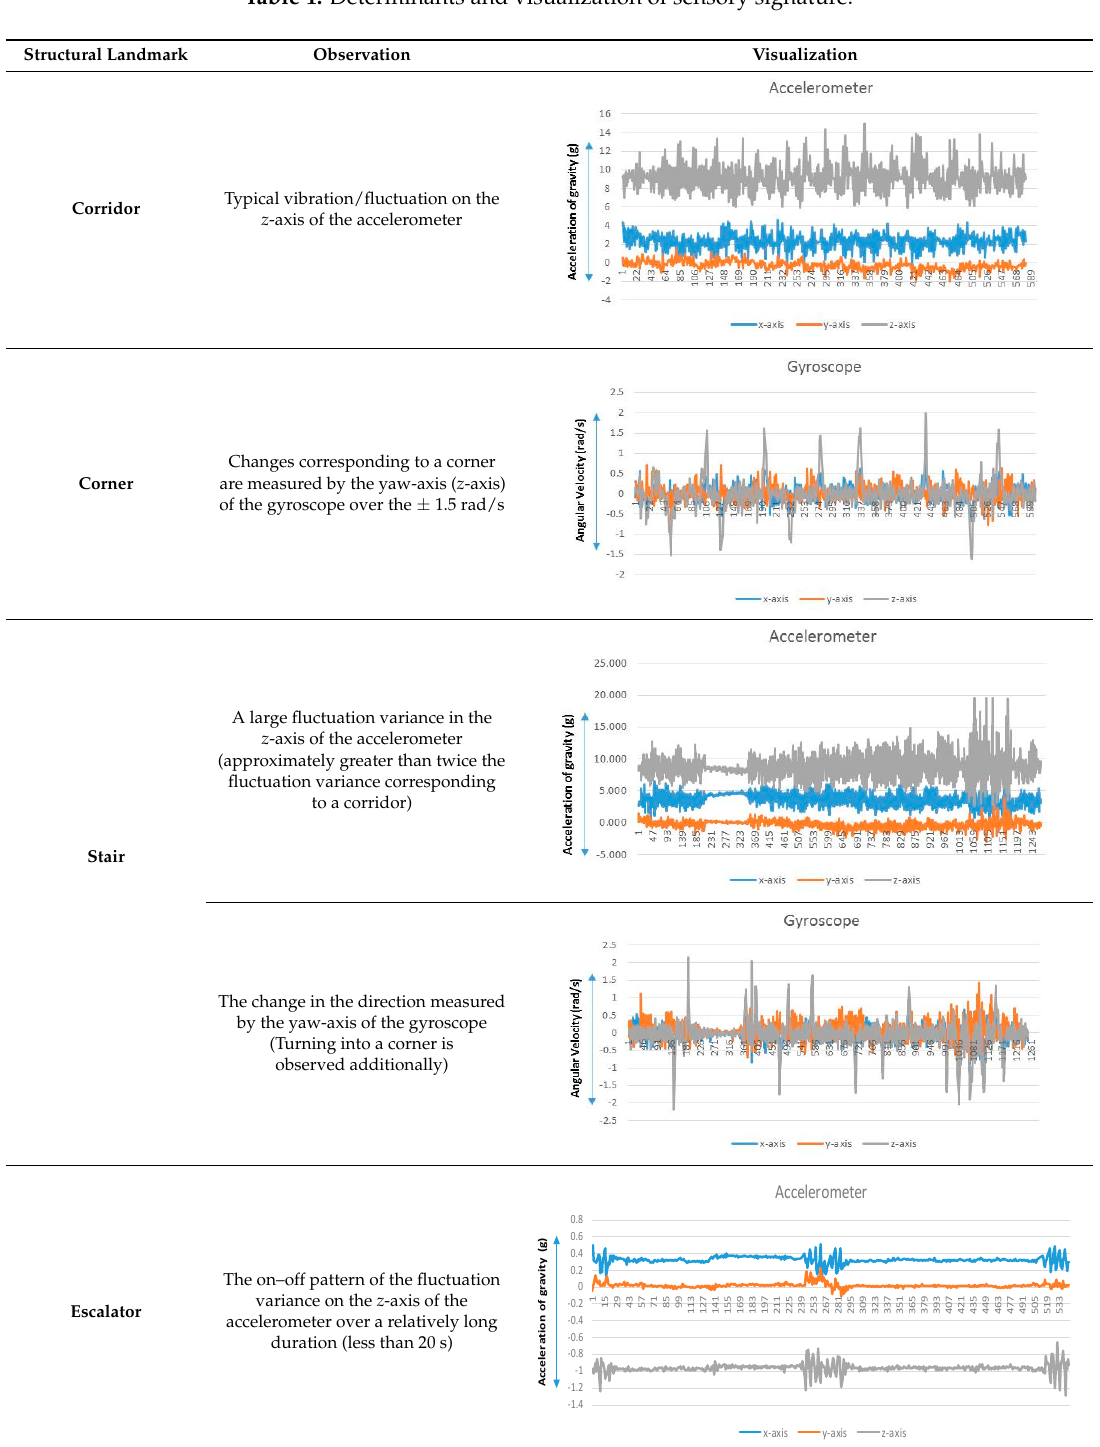
Table 1. Determinants and visualization of sensory signature.